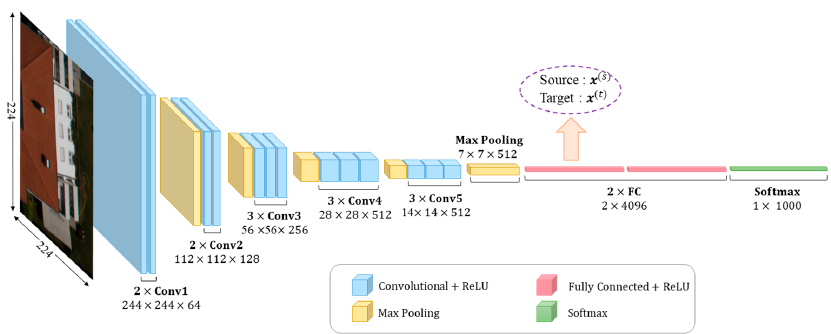
Figure 4. Feature extraction using a VGG16 pre-trained CNN.